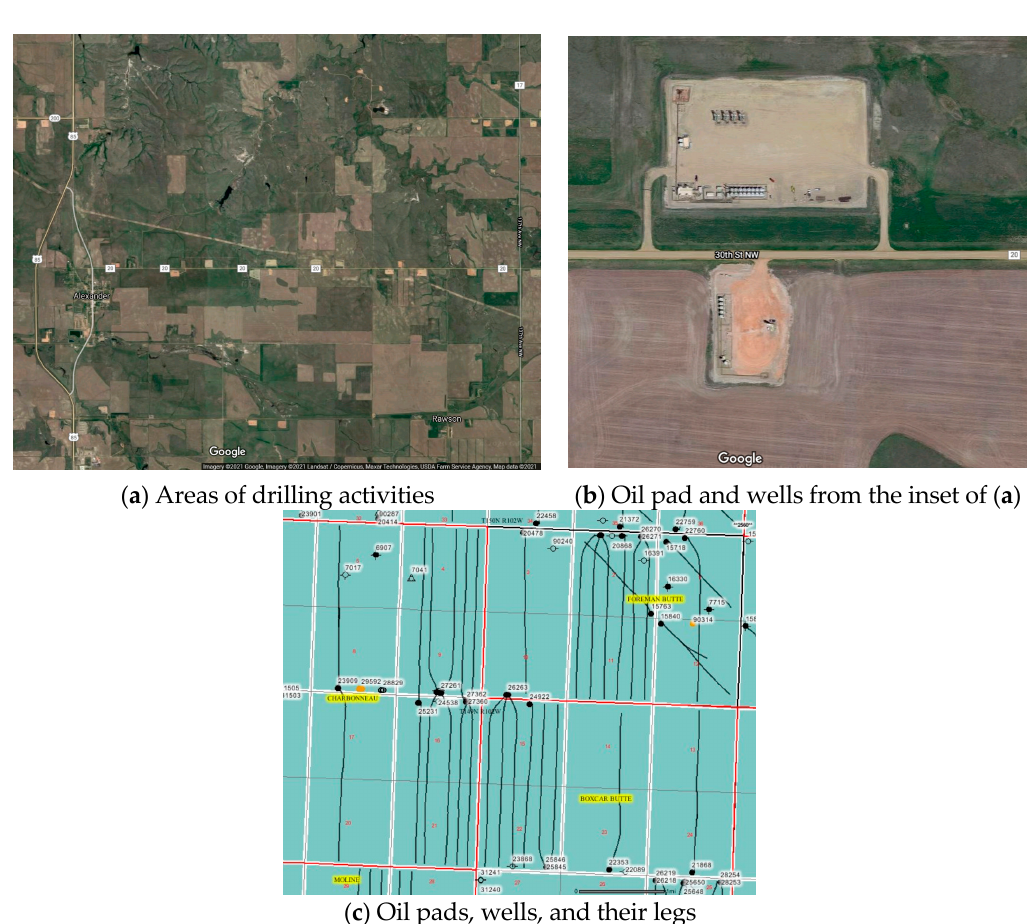
Figure 3. Aerial view of oil field and map of oil pads, wells, and their legs: sources of ( a , b ) from Google ® and ( c ) from [38].